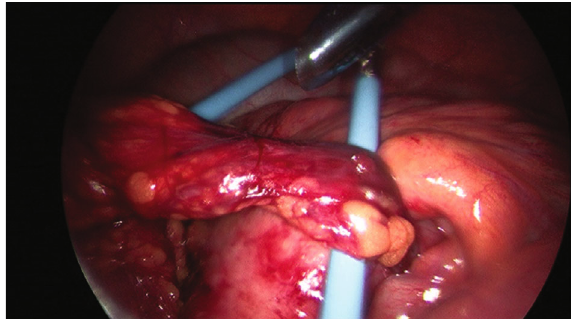
Figure 1: Band of omentum adhered to small bowel mesentery causing SBO.